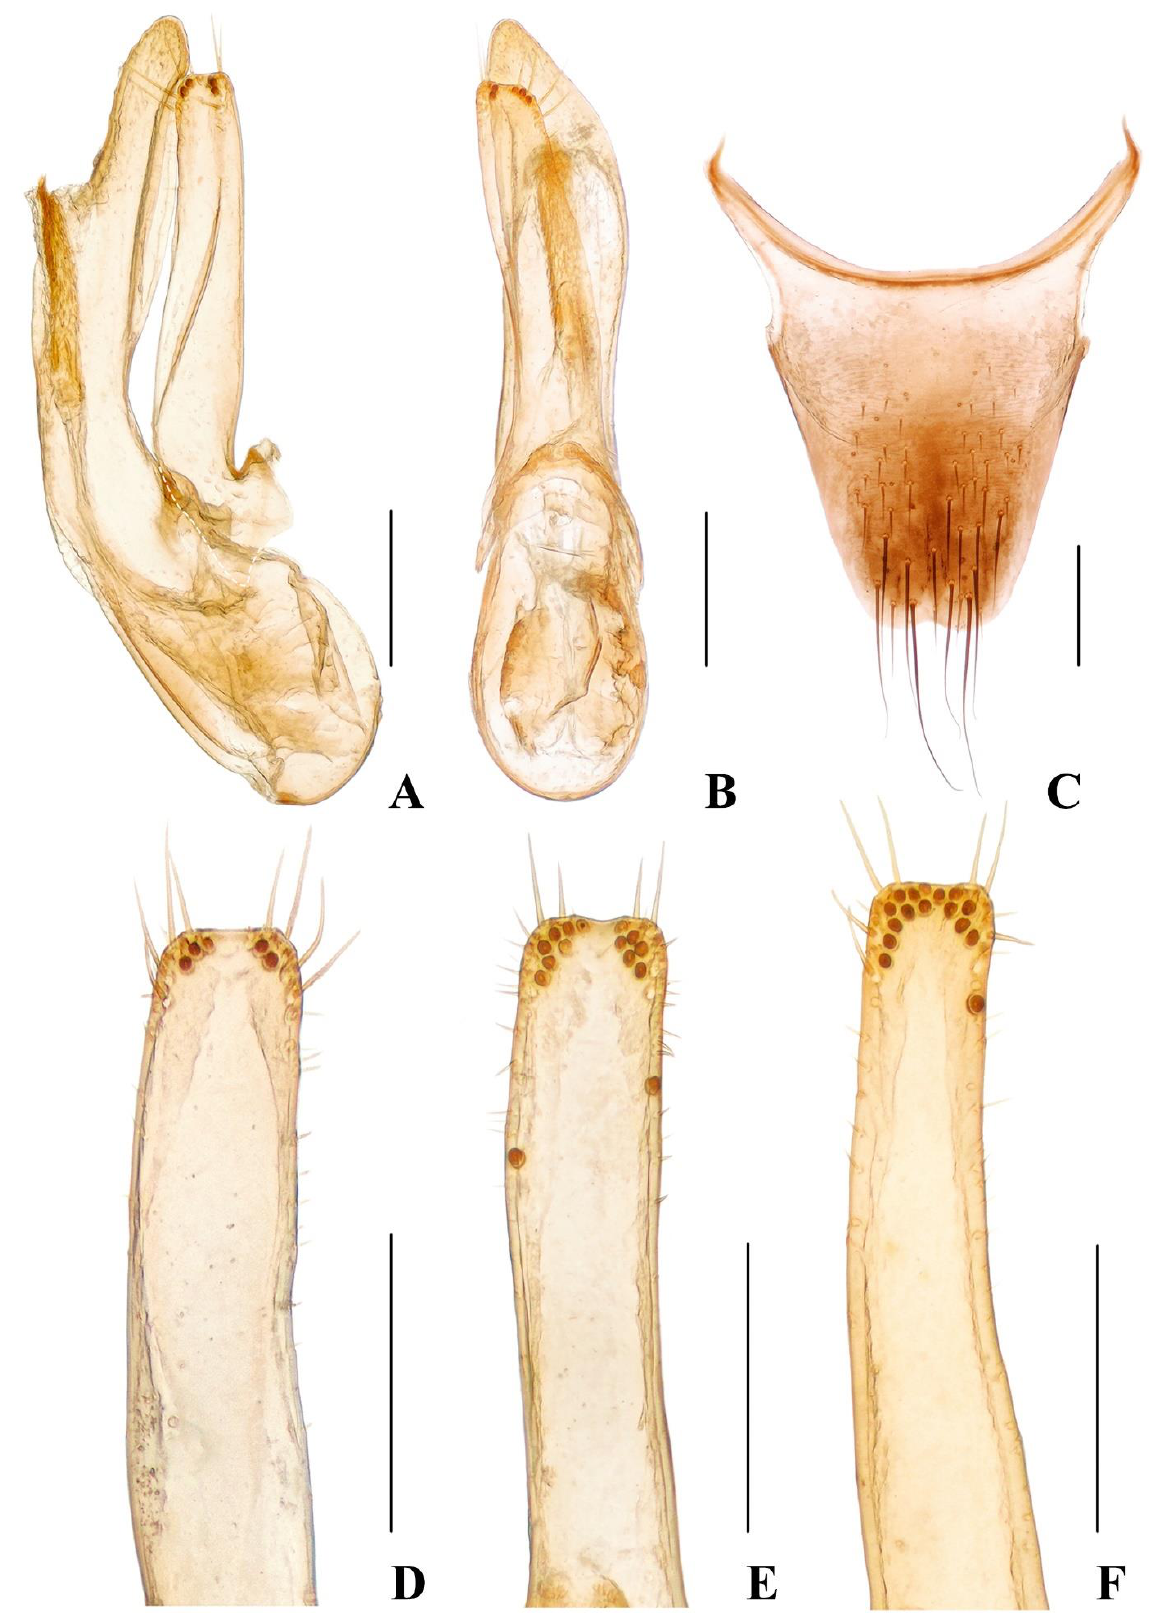
Figure 6. ( A – D ) Hesperoschema sinicum . ( A , B ) Aedeagus, lateral ( A ) and ventral ( B ) views; ( D – F ) paramere; ( C ) female abdominal tergite X . Scale bars = 0.2 mm.